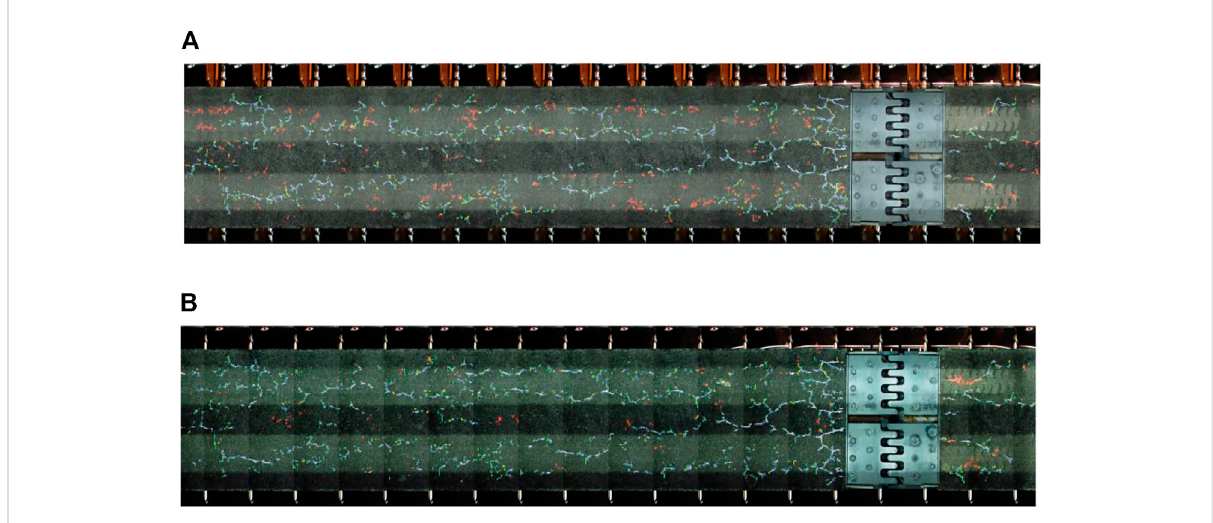
FIGURE 14 An example of Damage progression results. (A) Damage progression in running surface from 2014 to 2015. (B) Damage progression in running surface from 2015 to 2016.